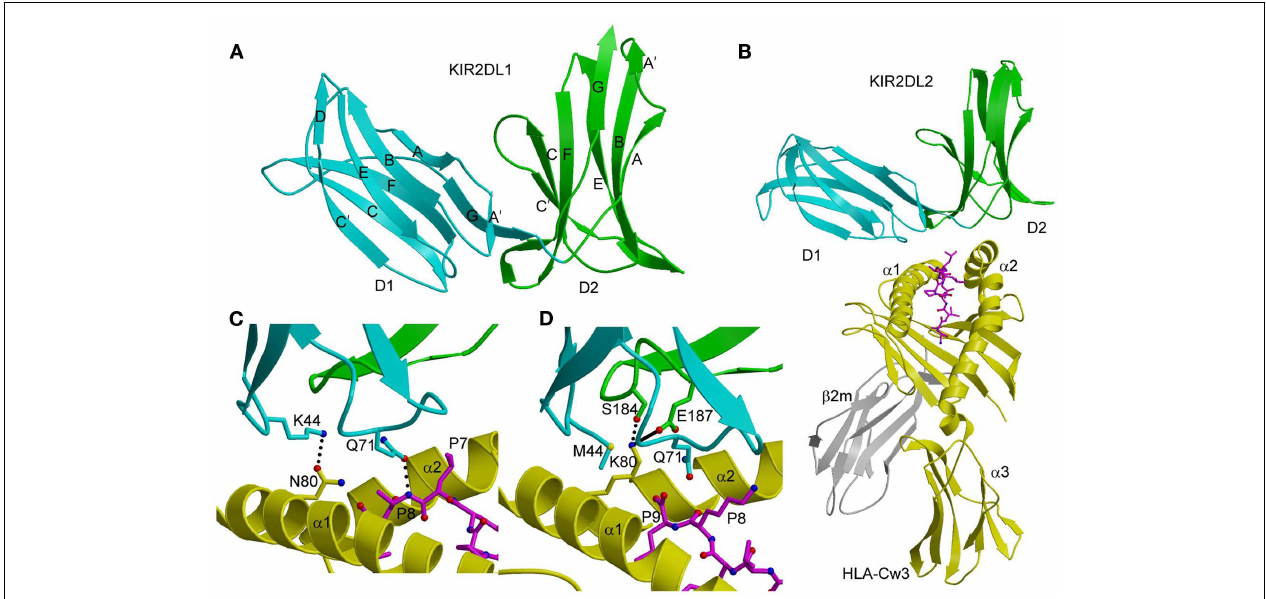
KIR2D receptors.The dotted lines represent hydrogen bonds formed by FIGURE 1 |Three-dimensional structures of KIR2DL and KIR2DL–HLA-C Asn80 of HLA-Cw3 with Lys44 of KIR2DL2, and by Gln71 of HLA-Cw3 with complexes . (A) Ribbon diagram of KIR2DL1 (PDB accession code 1NKR).The P8 of the peptide. (D) Interactions of Lys80 of HLA-Cw4 (yellow) with D1 domain is cyan; D2 is green.The secondary structural elements are specificity-determining residues of KIR2DL1 (D1 domain in cyan, D2 domain labeled. (B) Ribbons diagram of KIR2DL2 bound to HLA-Cw3 (1EFX).The α 1, α 2, and α 3 domains of the HLA-Cw3 heavy chain are yellow; β in green) in the KIR2DL1–HLA-Cw4 complex (1IM9).The solid line represents 2 m is gray; the a salt peptide is magenta. (C) Basis for allelic specificity and peptide selectivity of